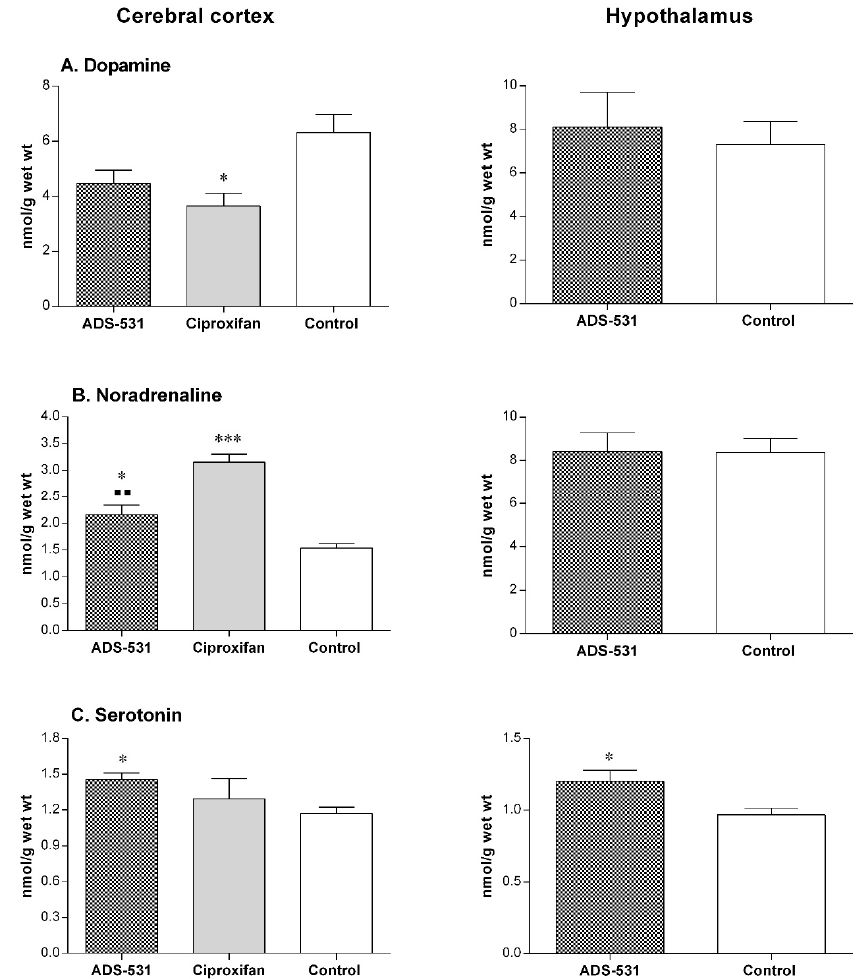
Figure 4. The cerebral concentration of biogenic amines’ in rats subchronically treated with reference Ciproxifan (s.c. 3 mg/kg/daily for five days) and ADS-531 (s.c. 3 mg/kg/daily for five days), the newly synthesized histamine H 3 receptor antagonist. DA—dopamine, NA—noradrenaline, 5-HT—serotonin. The values are means ± SEM for five to eight rats. One-way ANOVA and Tukey’s multiple comparisons (cid:4) test (cerebral cortex) or Unpaired t test (hypothalamus): * vs. Control, vs. Ciproxifan; a single symbols means p < 0.05, two symbols: p < 0.01, three symbols: p <